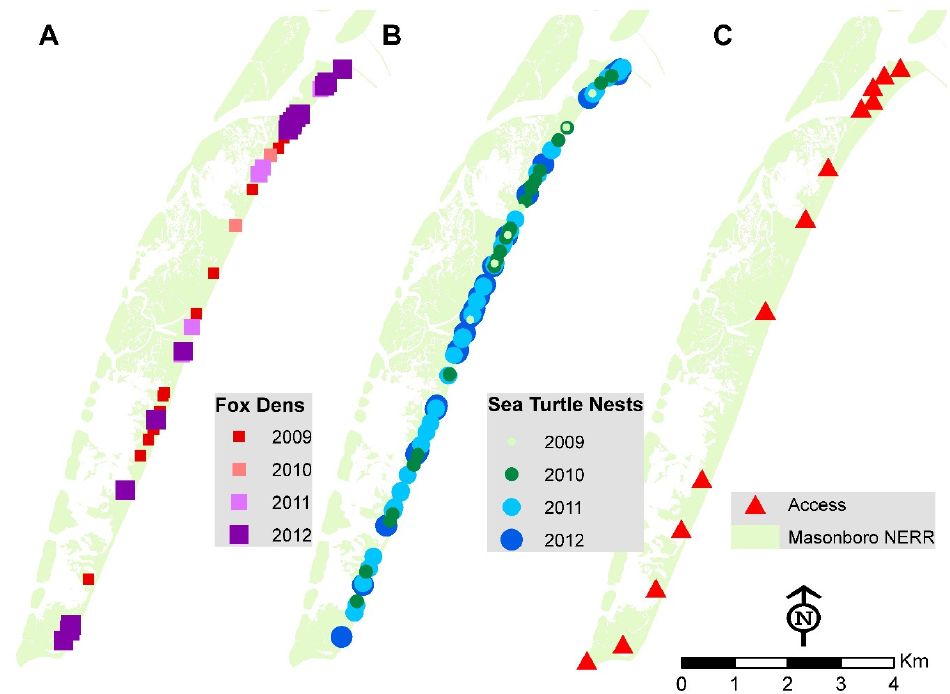
Figure 2. Location of: ( A ) red fox ( Vulpes vulpes ) den entrances; ( B ) sea turtle nests; and ( C ) access sites at Masonboro Island National Estuarine Research Reserve, North Carolina, USA (2009–2012).